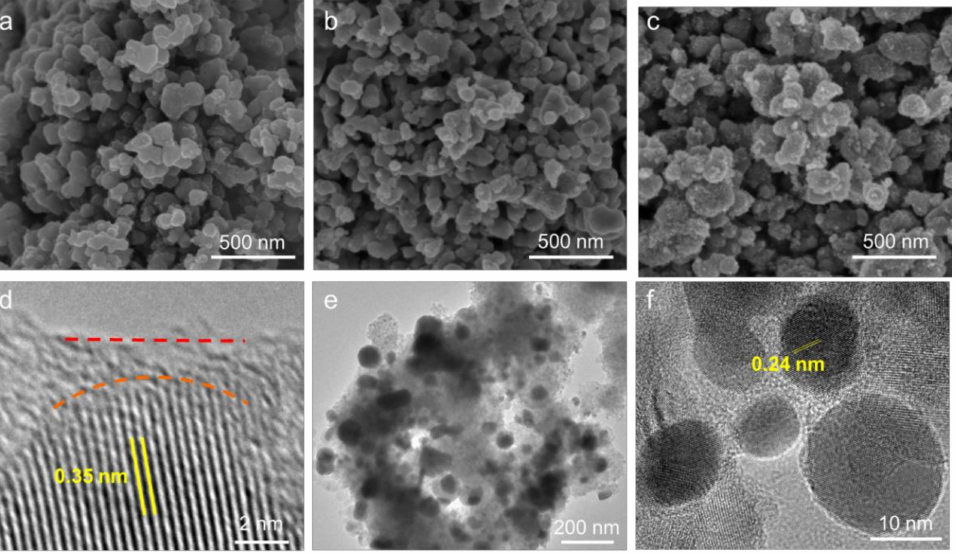
Figure 2. ( a ) SEM image of TiO 2 . ( b ) SEM image of b-TiO 2 . ( c ) SEM image of Ag/b-TiO 2 . ( d ) TEM image of b-TiO 2 . ( e , f ) TEM images of Ag/b-TiO 2